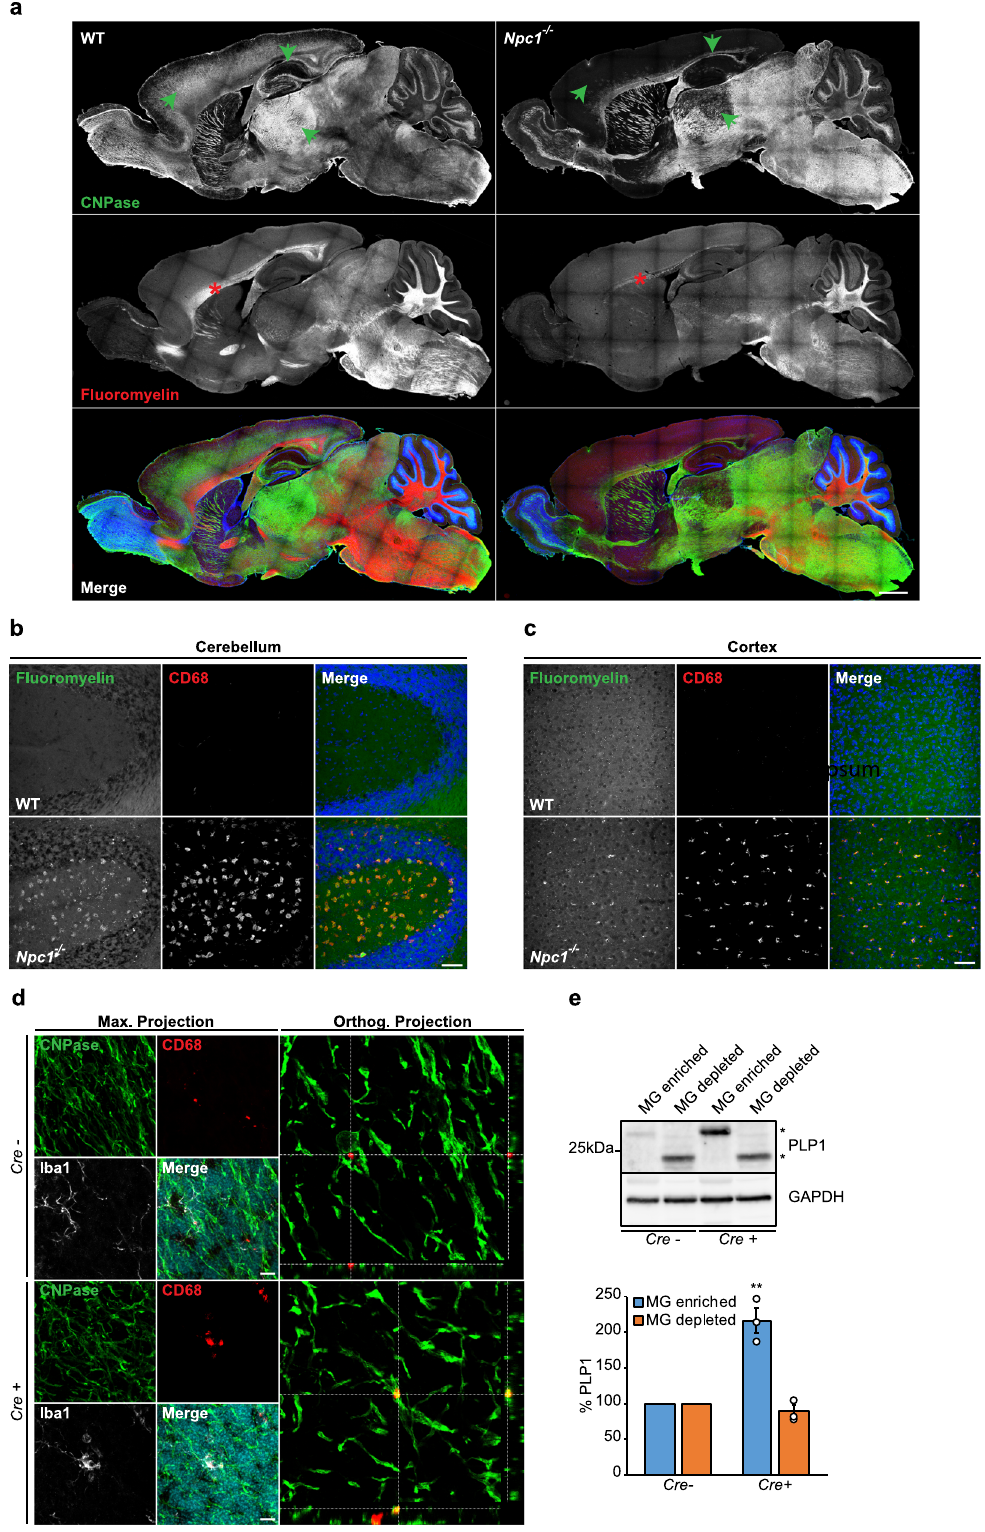
First, we performed a proteomic analysis of peripheral blood monocyte-derived macrophages from 7 NPC patients and 3 healthy controls (Fig. 8a, Supplementary Data 4). Despite the larger variability among the human samples, this analysis revealed a tendency of increased levels of late endosomal/lyso- somal and DAM proteins, including LAMP1/2, NPC2,